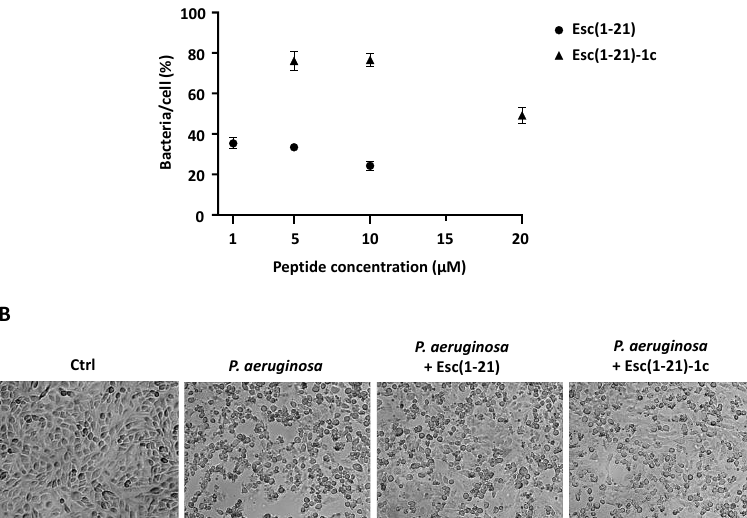
Figure 1. Effect of Esc(1-21) and its diastereomer Esc(1-21)-1c on Pseudomonas aeruginosa ATCC 27853 infected A549 cells. About 1 × 10 5 cells were seeded in 24-well plates. Upon reaching confluence, they were infected with P. aeruginosa for 2 h and then antibiotic treatment was performed to remove nonadherent extracellular bacteria. Afterwards, infected cells were left untreated or were treated for 1 h with each peptide at different concentrations. ( A ) The percentage of bacteria/cell was calculated with respect to untreated infected samples. All data are the mean from four independent experiments ± standard errors of the means (SEM). ( B ) Light microscopy images of A549 cells at ×10 magnification. Peptide-untreated uninfected cells are control samples (Ctrl).